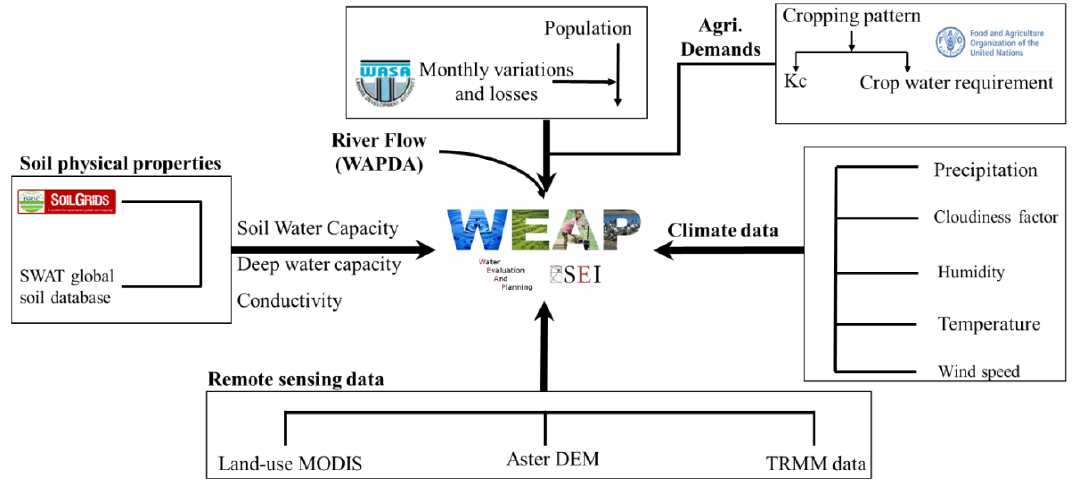
Figure 3. The study workflow and data inputs in the WEAP model.